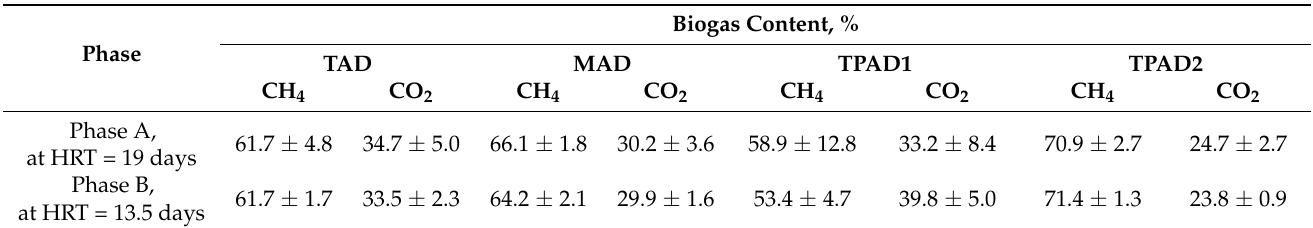
Table 5. Biogas composition.